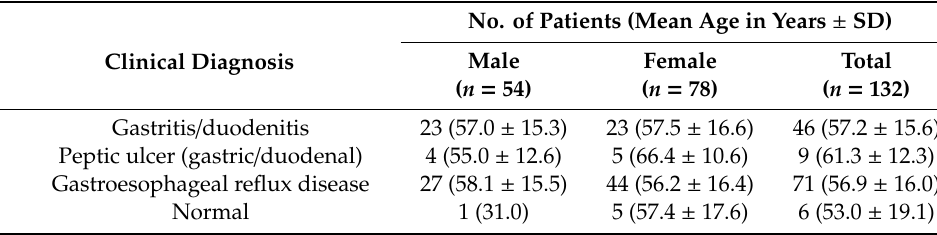
Table 1. Demographic and clinical features of studied